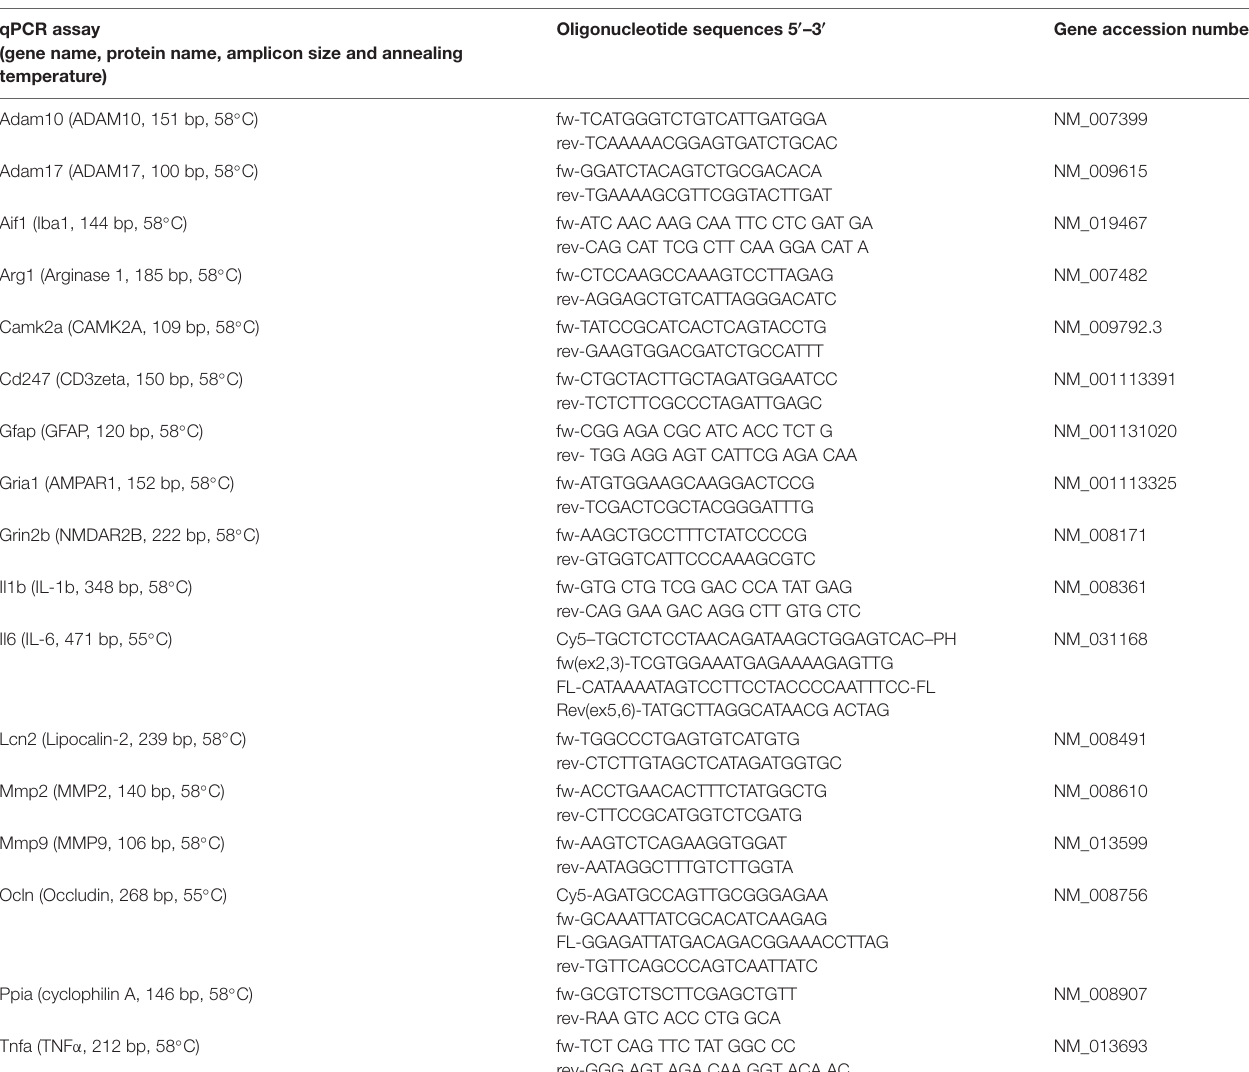
TABLE 1 | Oligonucleotide